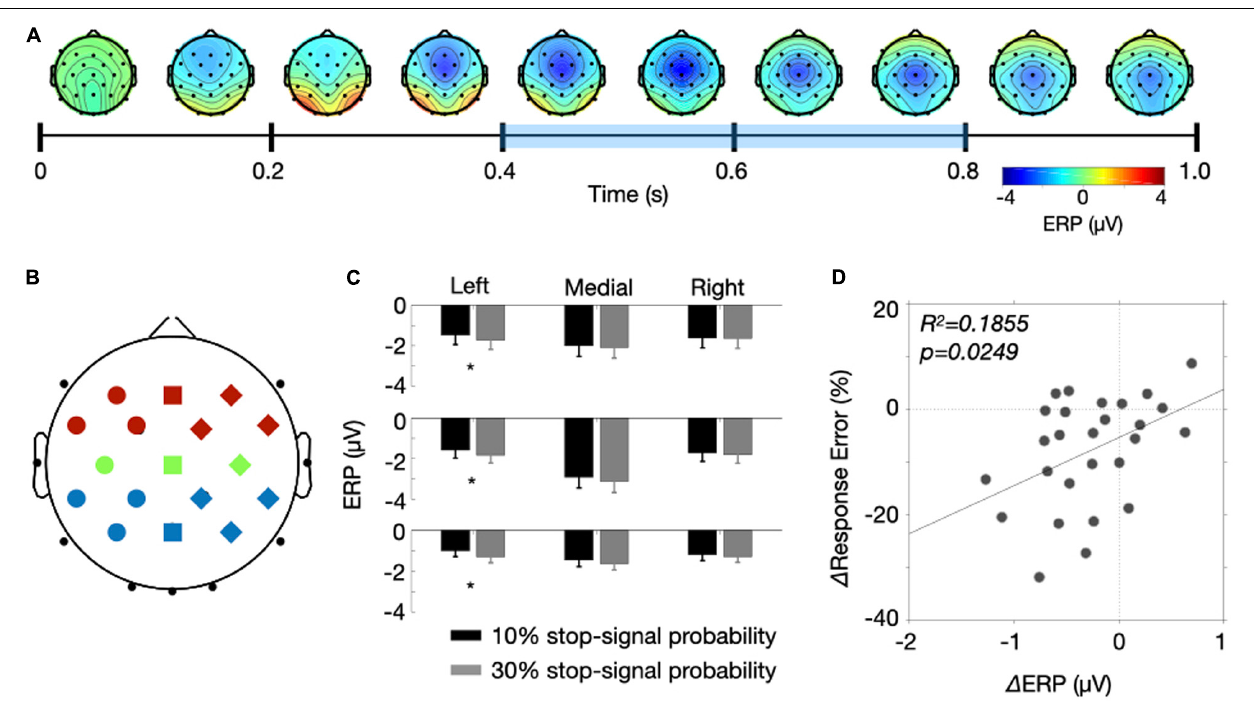
FIGURE 5 | Results of the collapsed localizers approach. (A) A time course of CNV modulations is represented by a series of topographies. Each topography was produced by averaging two probability conditions for 100 ms starting from 0 ms with 100 ms step size. The bluish color drawn over the time axis is the temporal window of interest. (B) A illustration of electrode assignment for 9 positions (anterior = red, central = green, posterior = blue X left = circle, medial = square, right = diamond). (C) ERP amplitudes for the two probability conditions were drawn for the nine electrode positions. Error bars were ± 1 S.E.M. (D) The response error differences of the stop-signal trials were plotted as a function of ERP differences between the two probability conditions. The solid line indicates a fitted